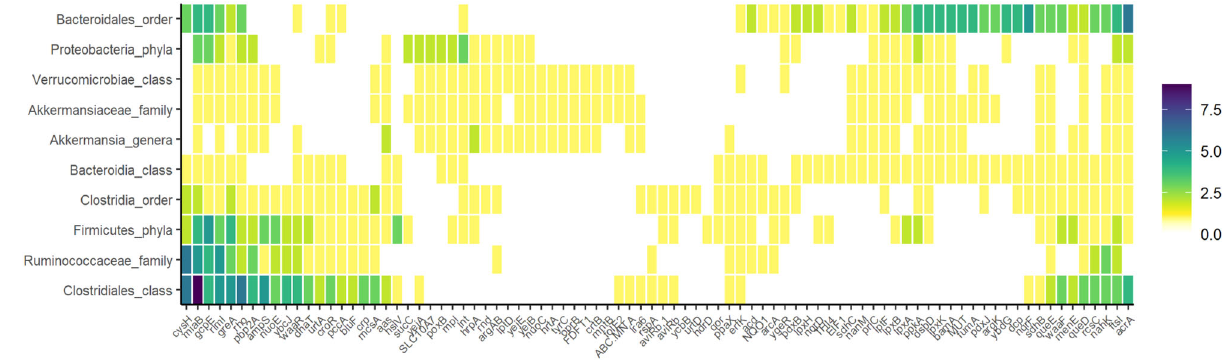
Fig. 3 Top 10 microbial taxa highly enriched with unique proteins classi fi ed within KEGG Orthologue groups (or microbial genes) presenting a correlated response to selection for intramuscular fat content. Color scale represents the number of unique proteins mapping into each KEGG Orthologue group (or microbial gene) identi fi ed within each taxa. Full names of microbial genes are given in Supplementary